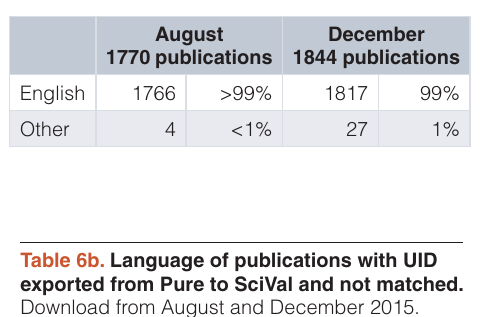
Table 6a. Language of publications with UID exported from Pure to SciVal and matched.